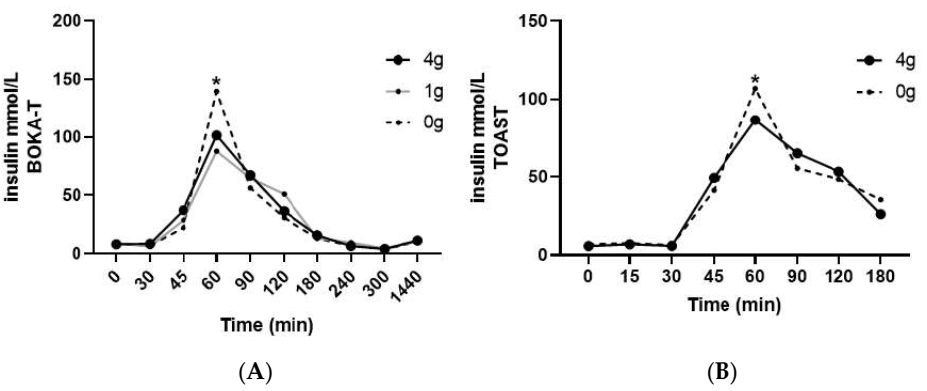
Figure 3. Mean ± SEM plasma concentrations of insulin for BOKA-T ( A ), and TOAST ( B ) throughout the postprandial period; 0 g (only hot water), 1 g (1 g kawakawa/250 mL hot water) and 4 g (4 g kawakawa/250 mL hot water). Differences between the treatment group over the postprandial were determined using repeated-measures ANOVA (* indicates p ≤